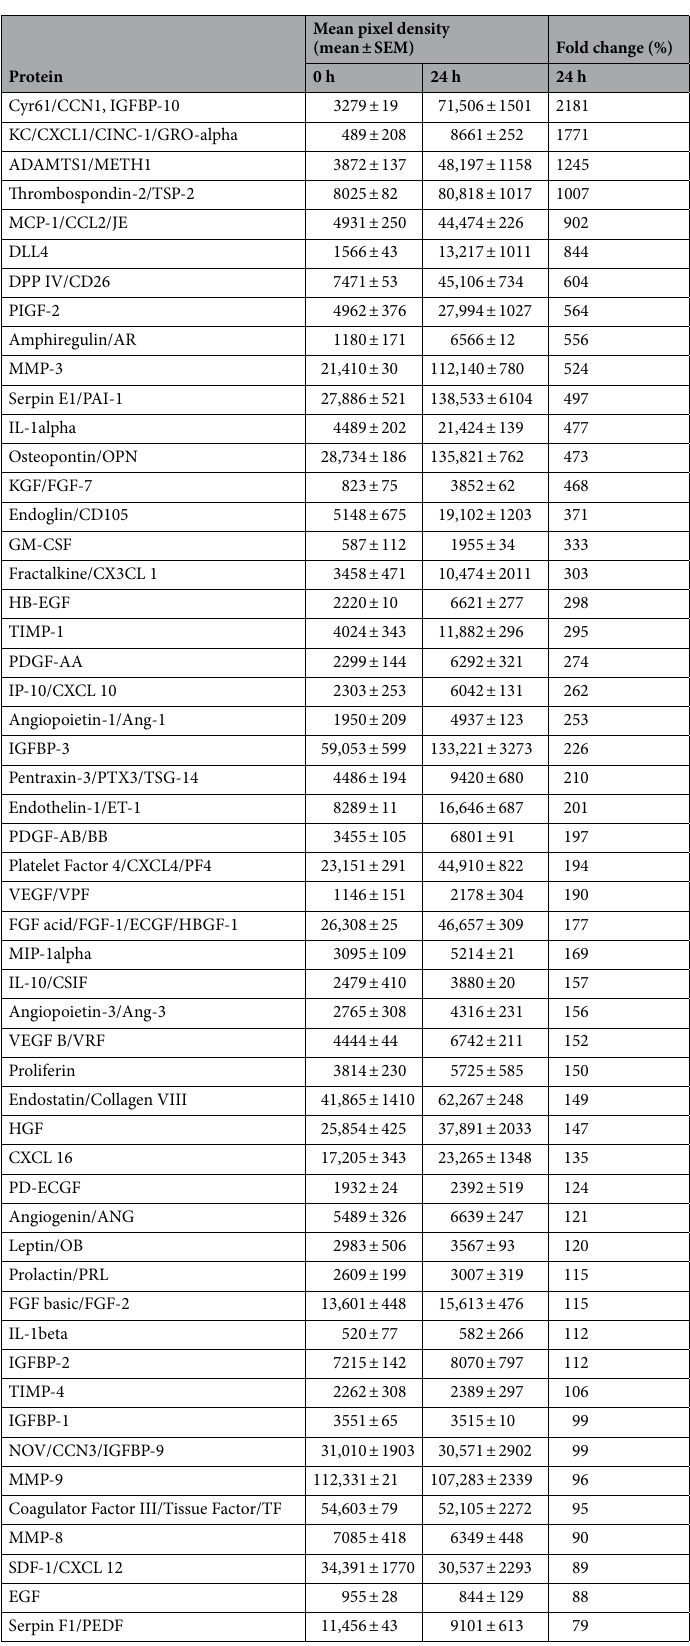
Table 1. Expression of angiogenesis-related proteins in 24-h-precultivated and freshly isolated uterine tissue samples as assessed by a proteome profiler mouse angiogenesis array. Data are presented as mean pixel density ± SEM of two technical replicates and as fold change in % of freshly isolated